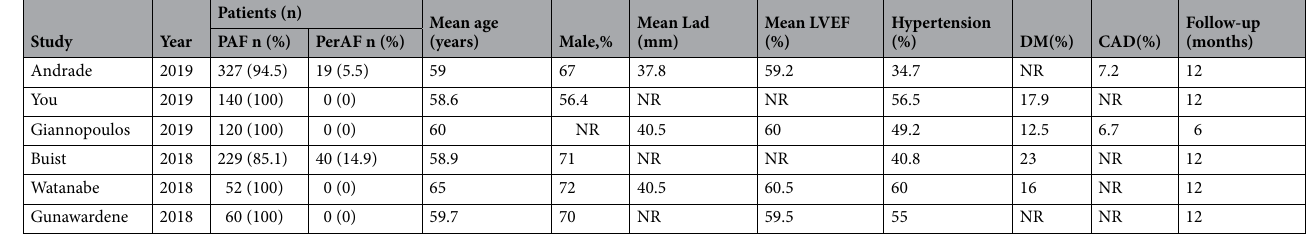
Table 1. Baseline characteristics of the included trials. PAF = paroxysmal atrial fibrillation, PerAF = persistent atrial fibrillation, LAd = left atrial diameter, LVEF = left ventricular ejection fraction, DM = diabetes mellitus, CAD = coronary artery disease, NR = not reported.